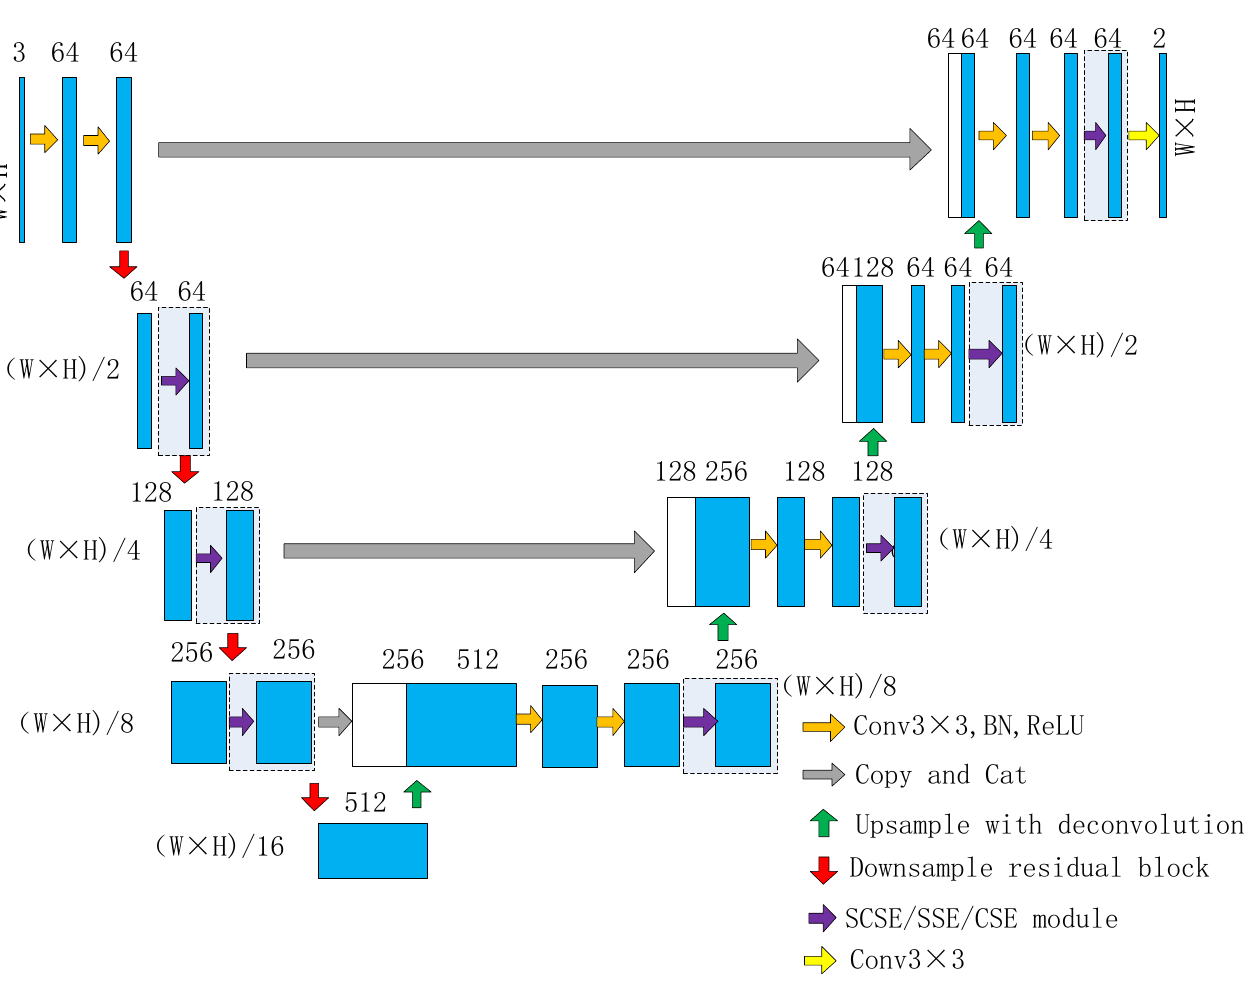
Figure 1. Proposed network architecture. The blue blocks and white blocks represent the feature map. The number above each block represents the number of feature channels it has. The orange arrows represent 3 × 3 convolution, BN, and ReLU layer. The red arrows represent the residual block for downsampling. The green arrows represent upsampling operation. The purple arrows represent various scSE modules. The dashed box indicates that this part can be selected as required.